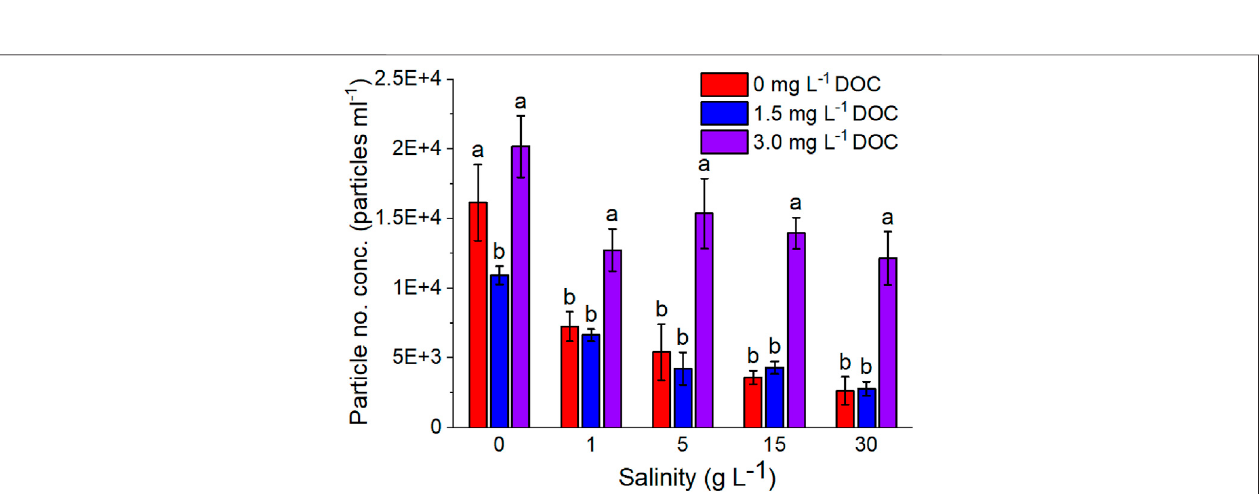
Frontiers in Toxicology |